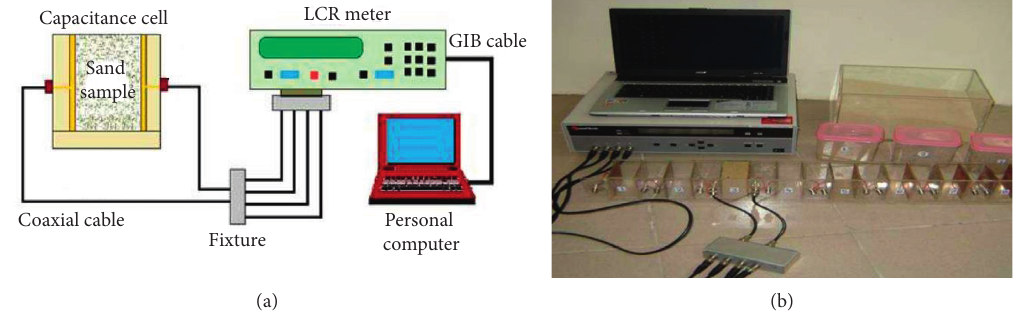
Figure 1: Dielectric capacitance cell. (a) Schematic diagram of DCC. (b) Prototype of lab DCC.